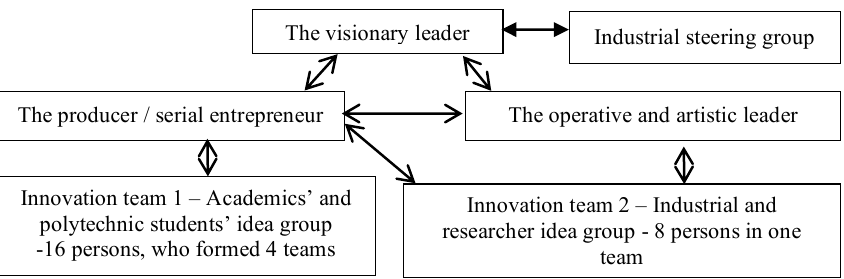
Fig. 6. The innovation group and its most important interaction relationships.